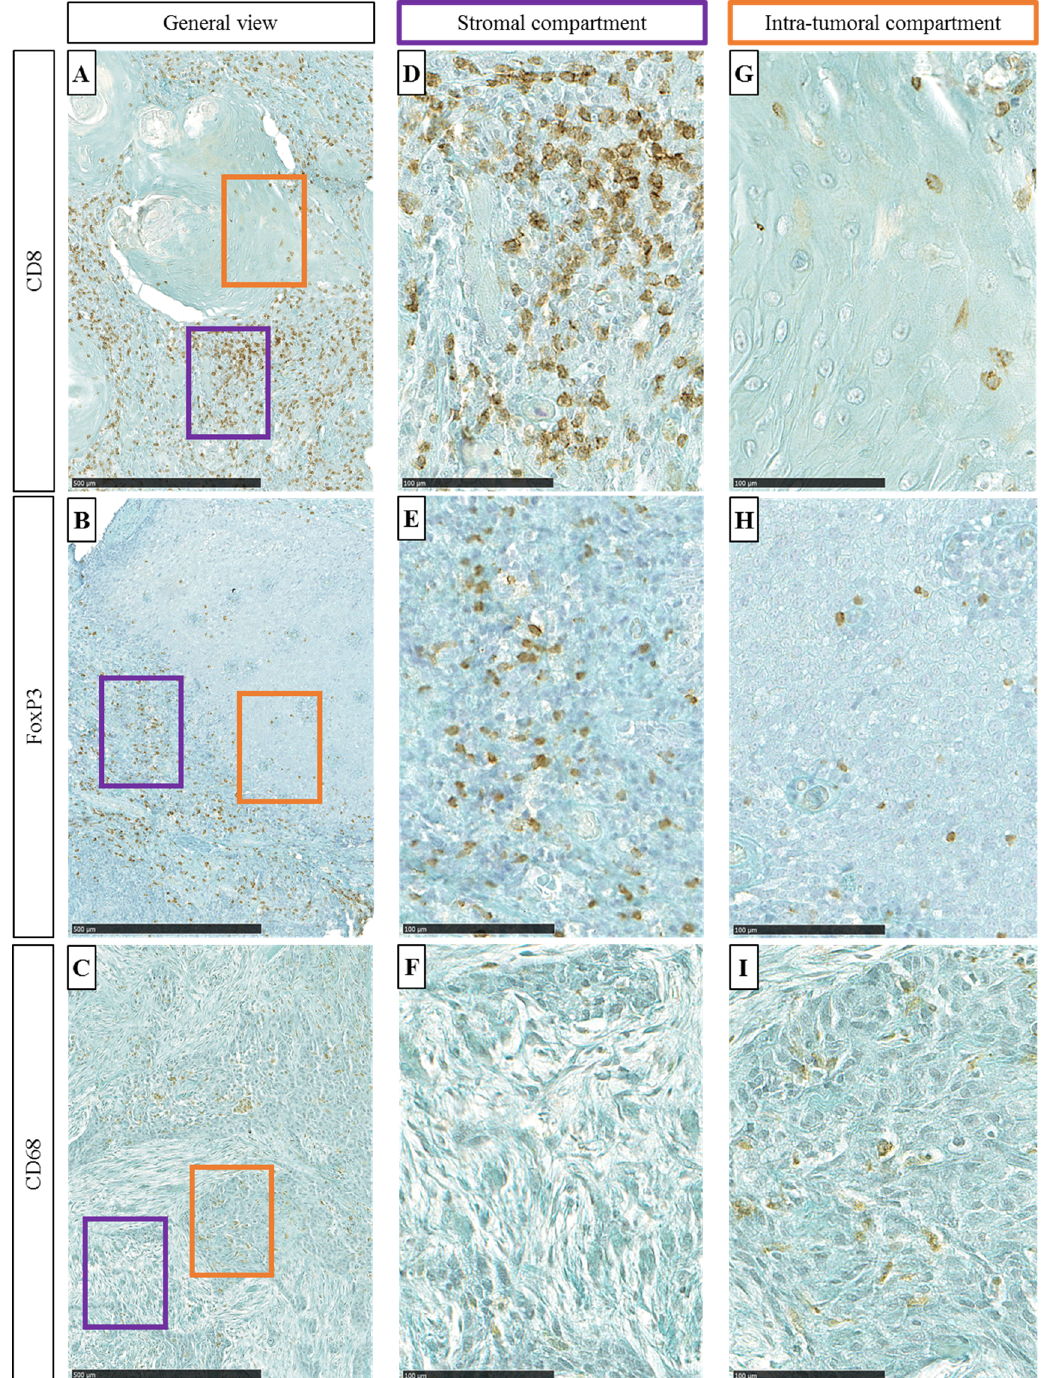
Figure 2. (( A – C ), respectively) General view of CD8, FoxP3, and CD68 immunohistochemical staining